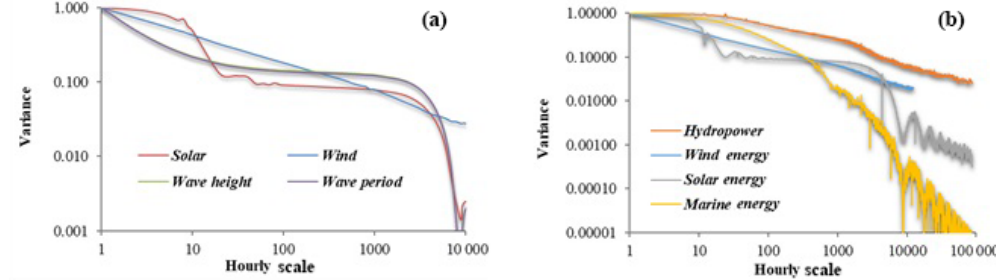
Figure 7. Climacograms demonstrating the uncertainty among hydrometeorological processes (a) and the various renewable energy tech- nologies (b) investigated in the case study of Astypalaia